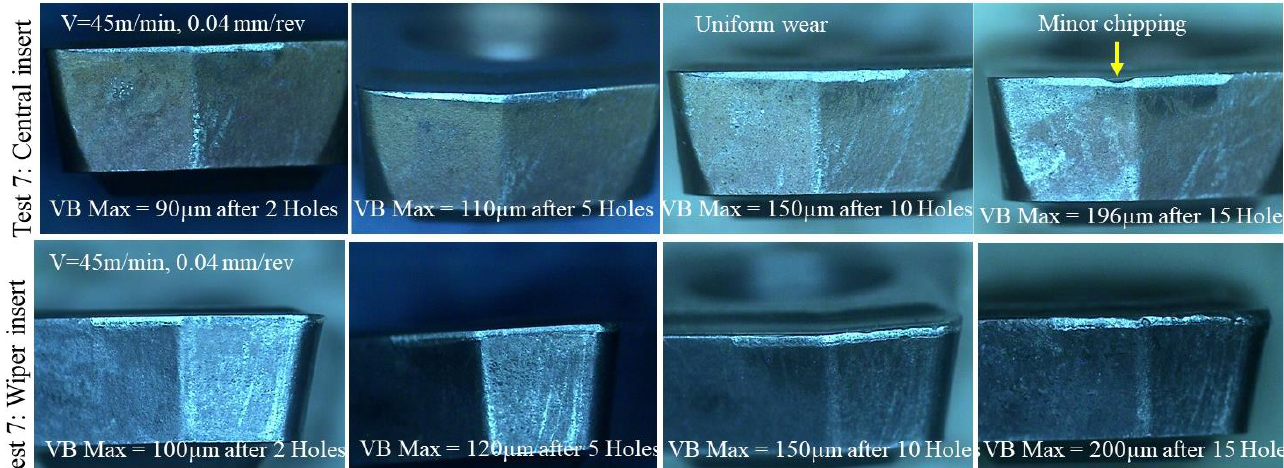
Figure 14. Wear evolution of Test 7 for central and wiper inserts.